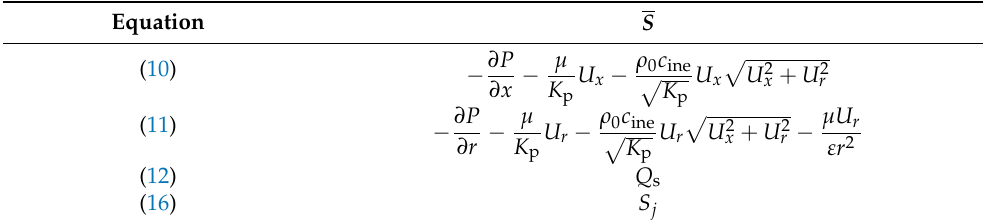
Table 2. Source terms in Equation